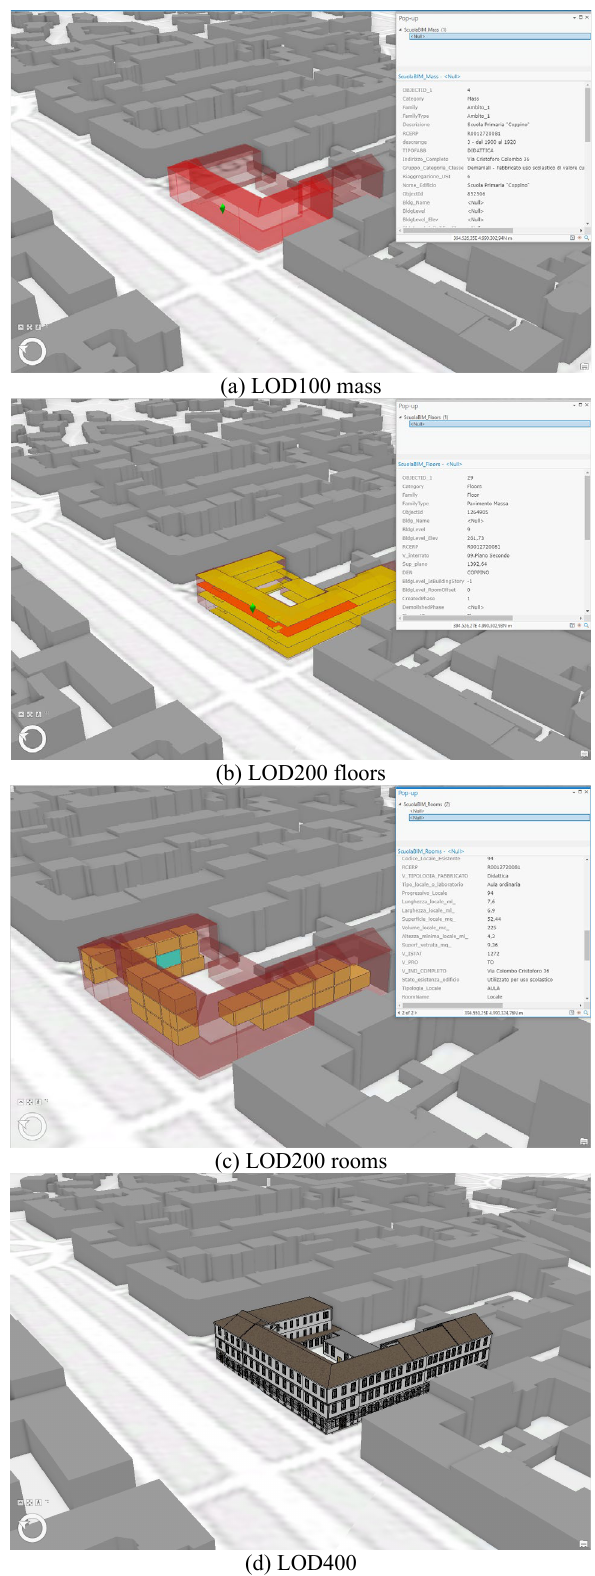
Figure 9. The Scuola Coppino multi-scale parametric model migrated into the Digital Twin at different LODs